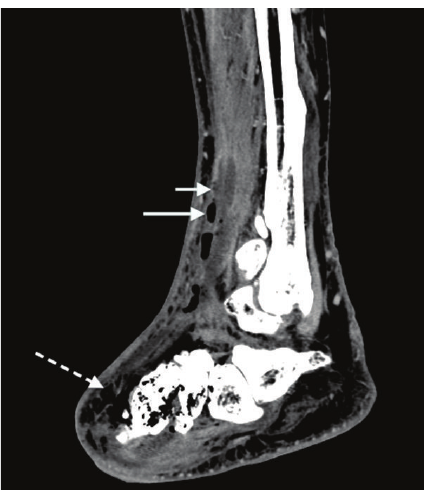
Figure 3: Computed tomography demonstrates soft tissue abscess formations anterior to the distal tibia with fluid (short arrow) and air-fluid levels (long arrow). Gas locules in the midfoot bones and extensive subcutaneous gas involving predominantly the dorsum of the foot (dashed arrow) and anterior aspect of the ankle are evident.